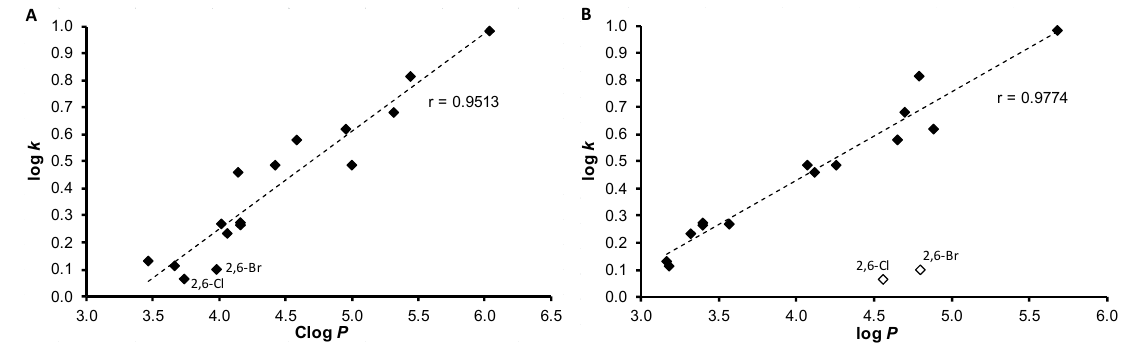
Figure 1. Comparison of experimentally found log k values of ring-substituted N -arylcinnamamides 1 – 16 with Clog P calculated using ChemBioDraw Ultra ( A ) and log P calculated using ACD/Percepta ( B ).